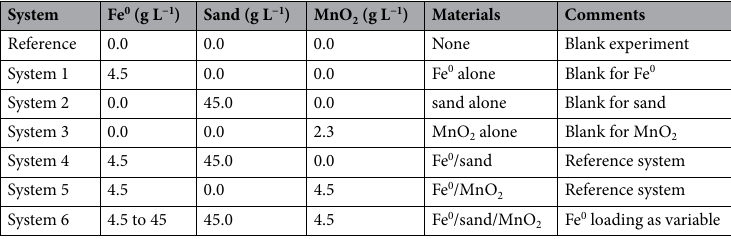
Table 3. Overview on the six (6) investigated systems. The material loadings correspond to Fig.